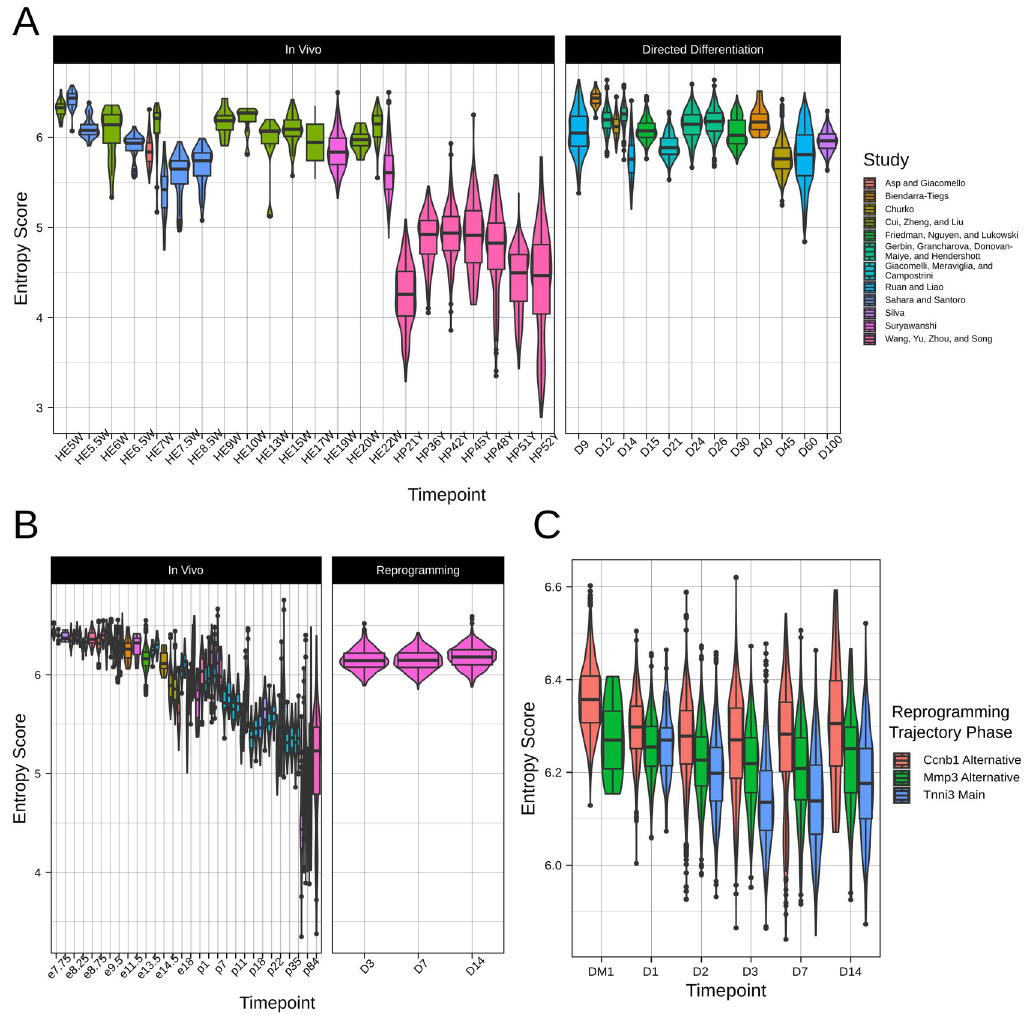
Fig 5. Entropy score quantifies maturation status of PSC-CMs and iCMs. A . Comparison in entropy score between human in vivo CMs and human PSC-CMs. Left side of figure reproduced from Fig 4B . B . Comparison in entropy between mouse in vivo CMs and mouse iCMs. Left side of figure reproduced from Fig 4B . C . Entropy score for three reprogramming pathways—a canonical Tnnt2+ iCM pathway and two alternative pathways (Ccnb1+ and Mmp3+).